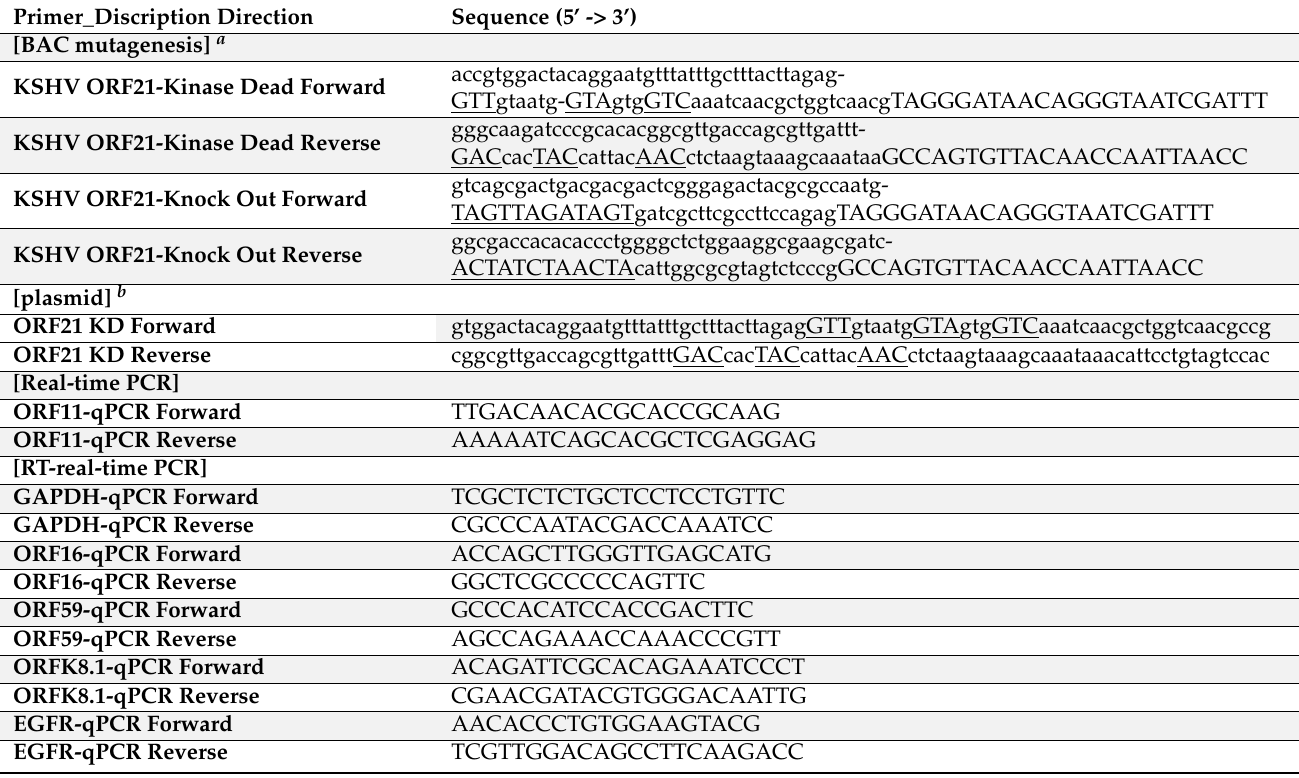
Table 1. Primers for BAC mutagenesis, construction of expression plasmids, real-time PCR, and RT real-time